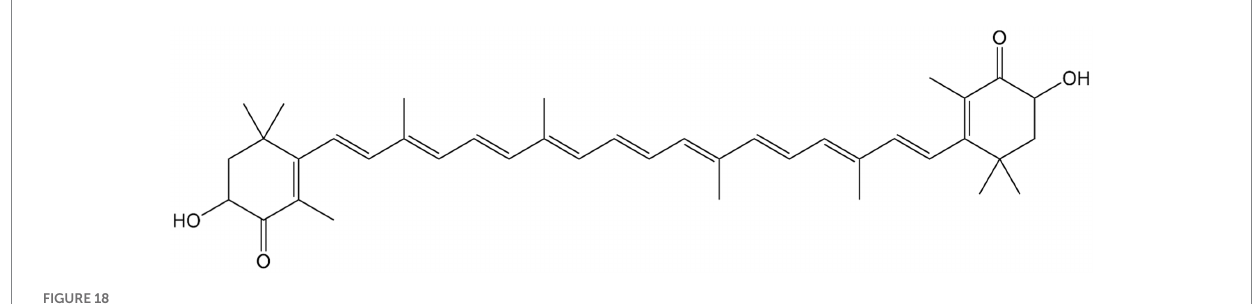
FIGURE 18 Chemical structure of